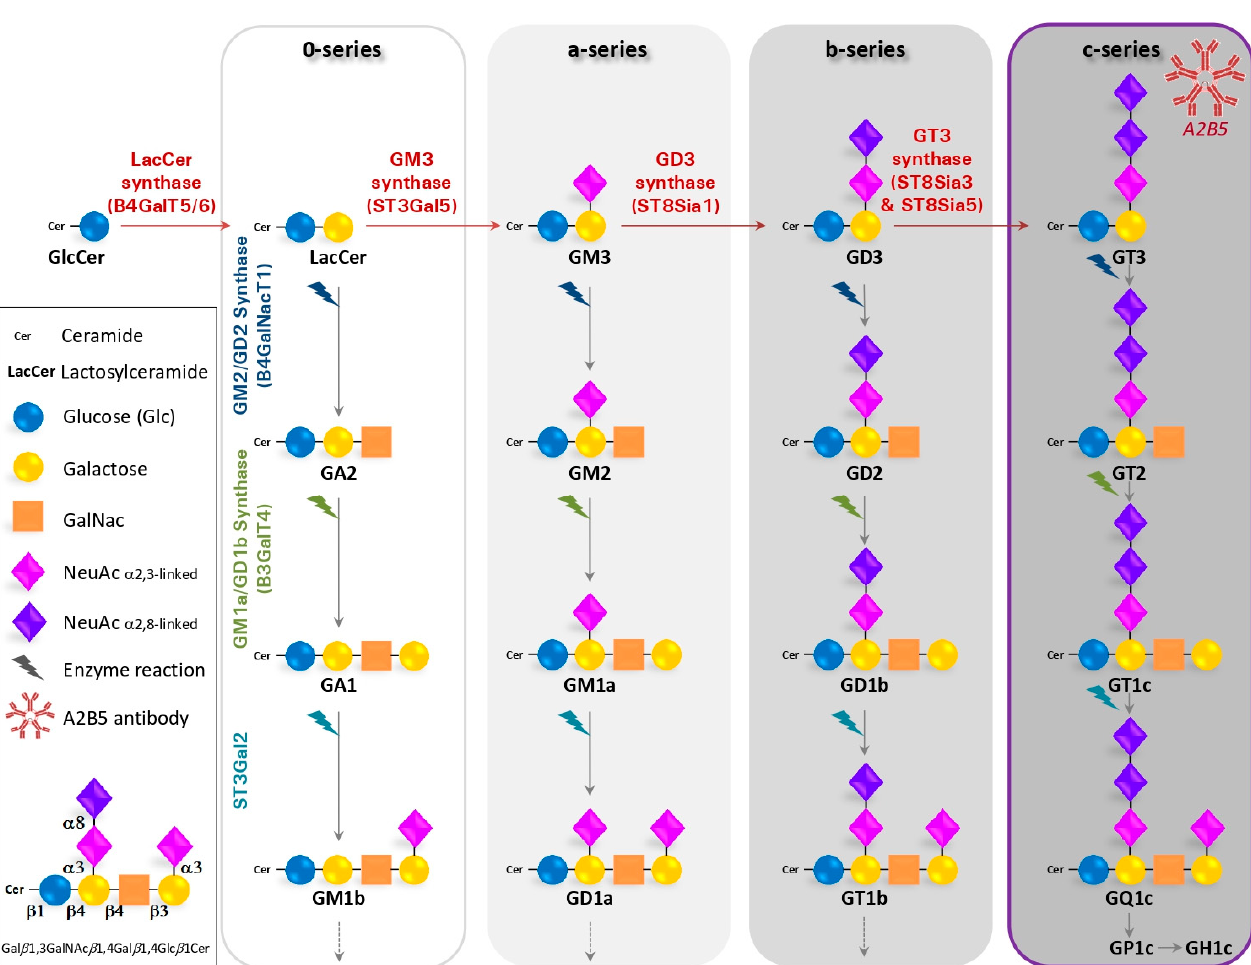
Figure 1. Schematic biosynthesis pathway for gangliosides.